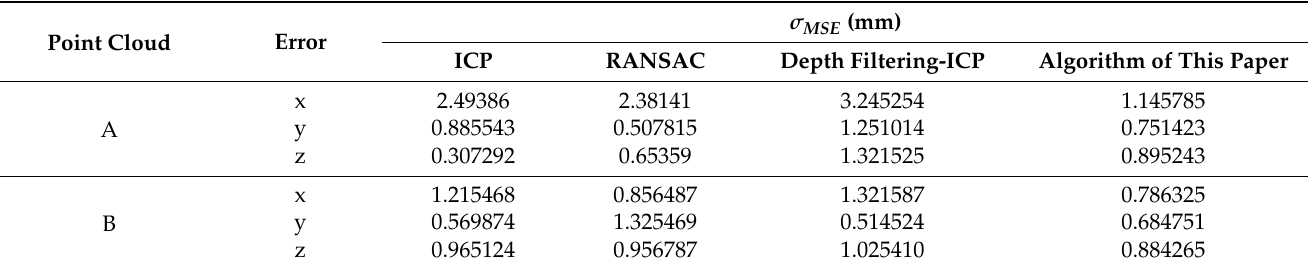
Table 4. Comparison of mean square error of the 4